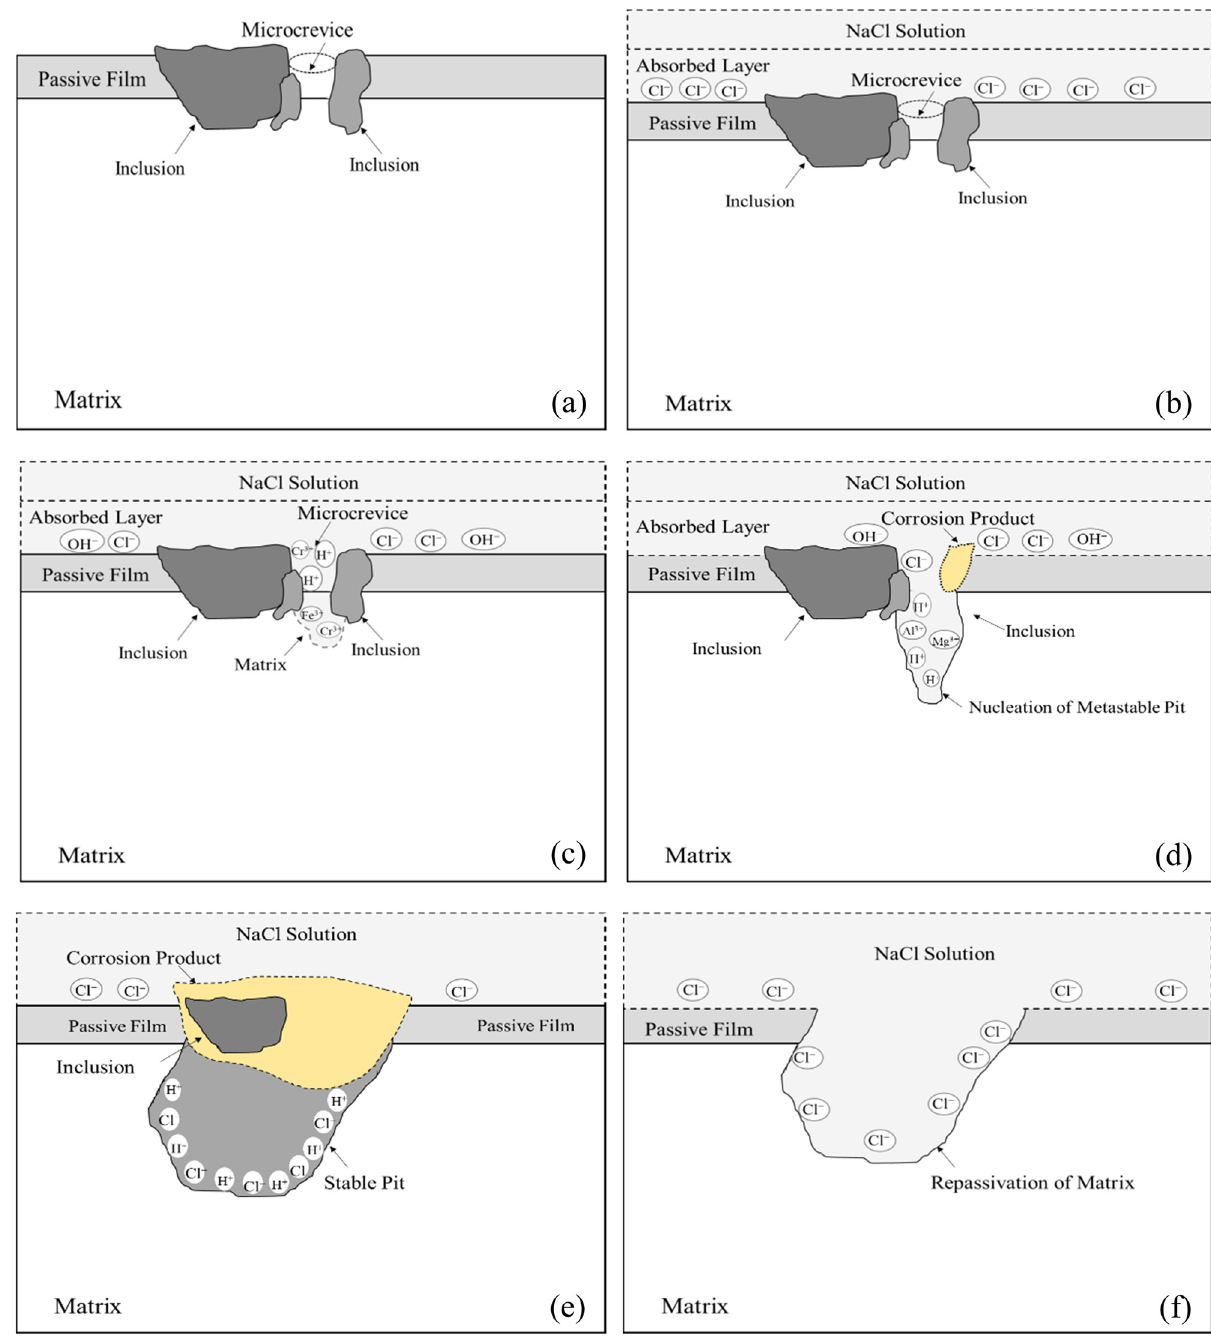
Figure 11: Mechanism of initiation and propagation of pits nucleated at inclusions in solution containing chloride ions. ( a ) Microcrevices between inclusion and matrix; ( b ) Cl − adsorbtion; ( c ) Formation of galvanic corrosion; ( d ) Nucleation of metastable pit; ( e ) Formation of closed autocatalysis corrosion cell; ( f ) Dissolution of